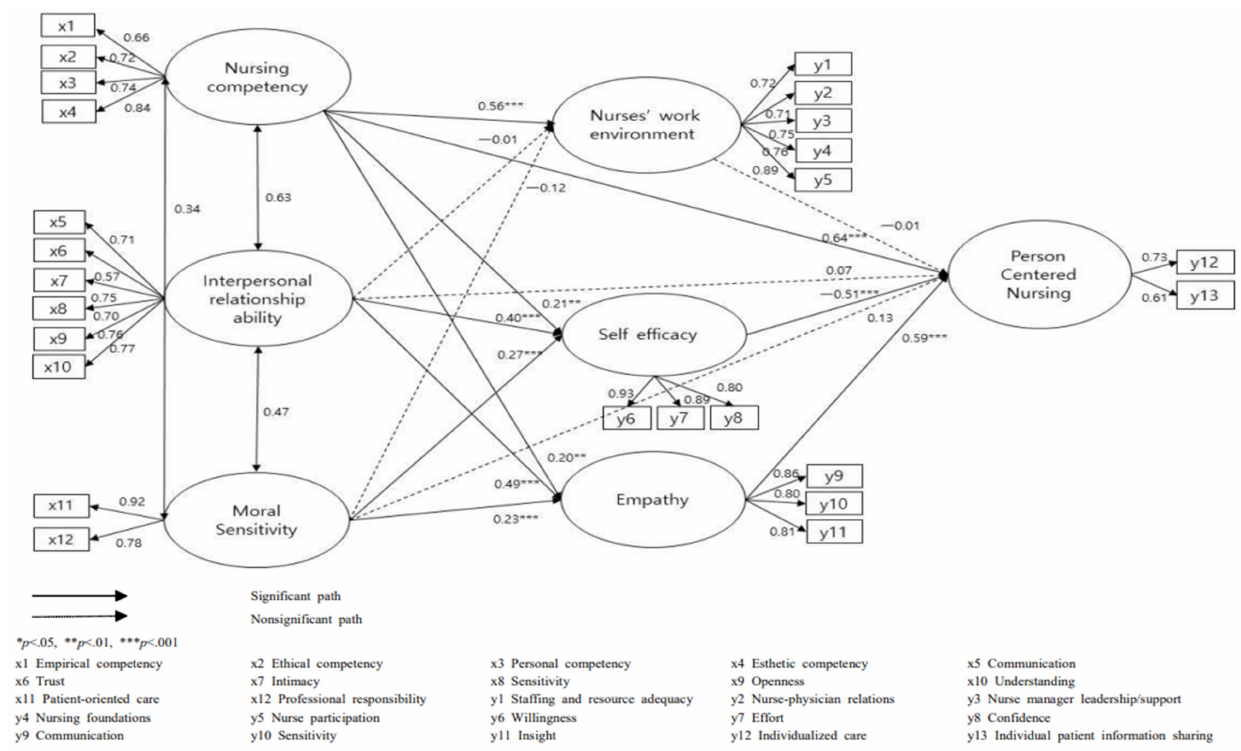
Figure 2. Path diagram of the hypothetical